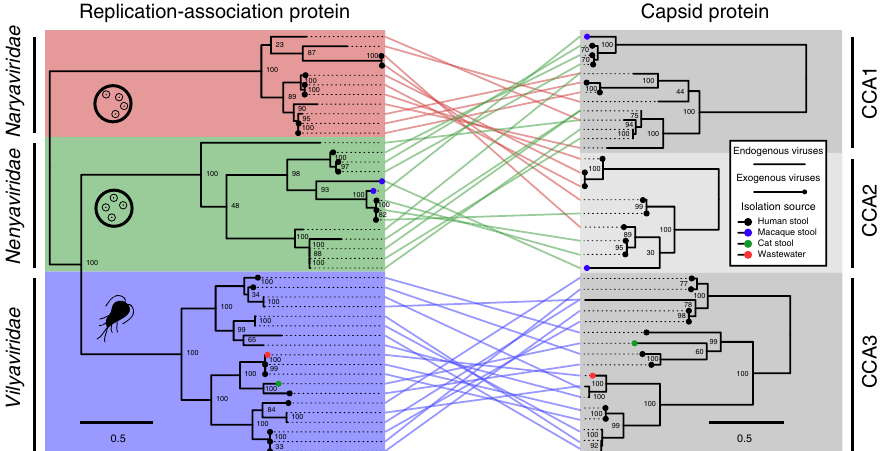
Fig. 4 Recombination of genetic modules between virus families infecting the same host. Phylogenetic maximum-likelihood trees of viral Rep and Cap proteins, scale bars refer to amino acid substitutions per site, numerical values represent bootstrap support. Lines connect genes from the same virus or physically close endogenous viral genes. Pictograms of Entamoeba (tetranucleate cyst stage) and Giardia ( fl agellated trophozoite stage) are shown to indicate virus host. CCA = CRESS virus Cap